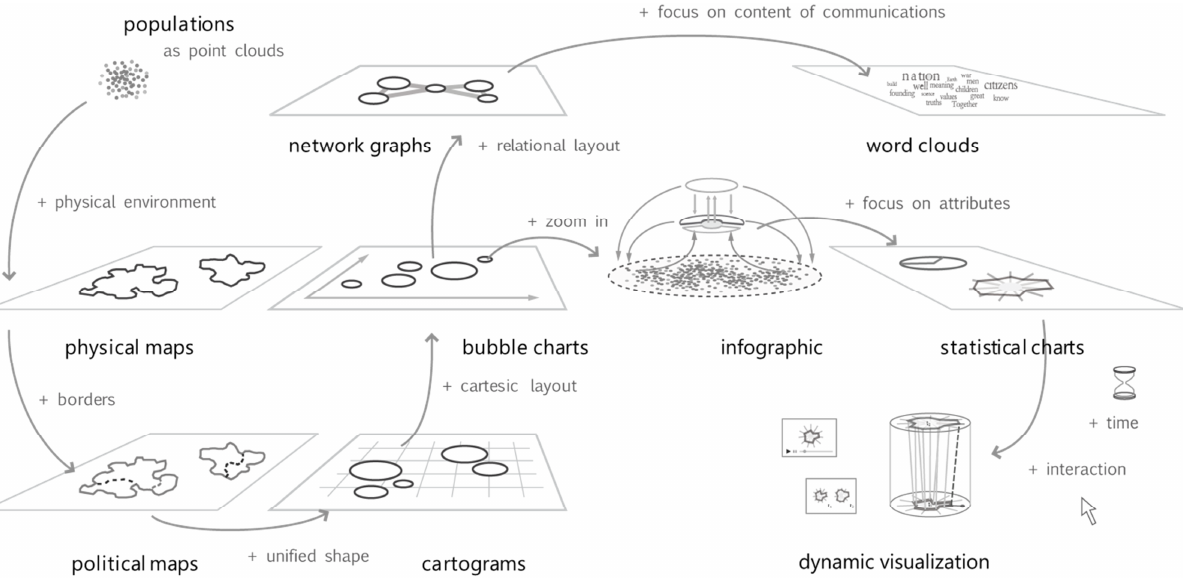
Figure 5: Supporting the preservation of the mental map by smooth transitions between different types of standard diagrams, used in visual communication of political data (cf. Windhager & Smuc,